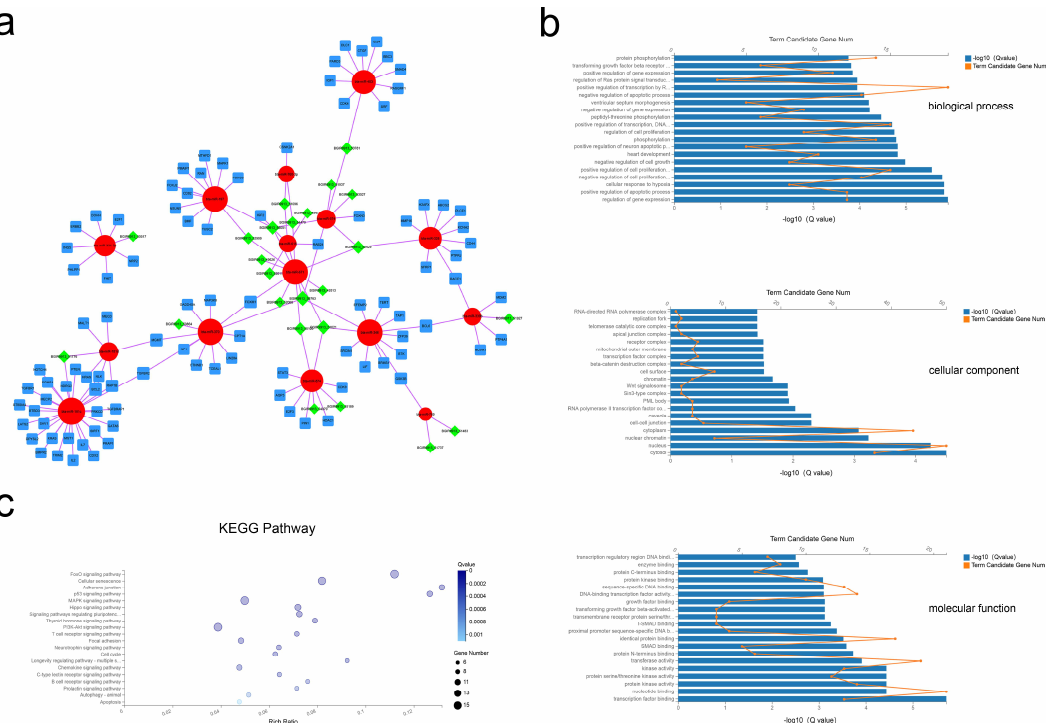
Figure 6. Exosomal lncRNA–miRNA–mRNA network construction and analysis. ( a ) Global view of the exosomal lncRNA–miRNA–mRNA network, including 24 lncRNAs (green diamonds), 15 miRNAs (red circles), and 102 mRNAs (blue squares). ( b ) The 20 most enriched GO terms including biological process, cellular component, and molecular function. ( c ) Advanced bubble chart of the 20 most enriched KEGG